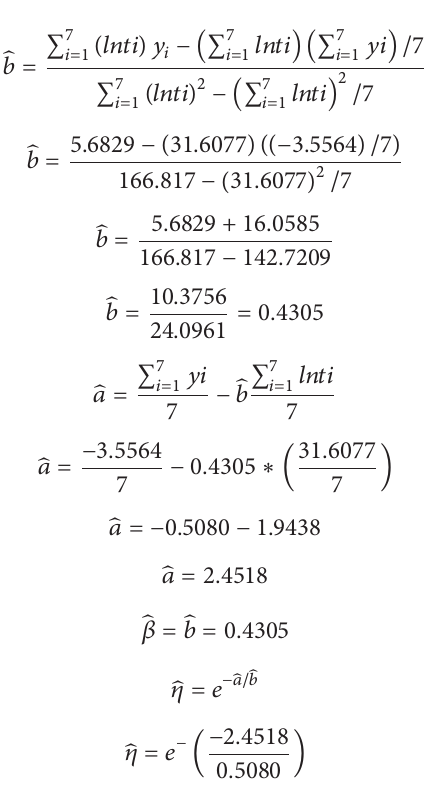
noncompilation of safe operating procedure, and improper installation of